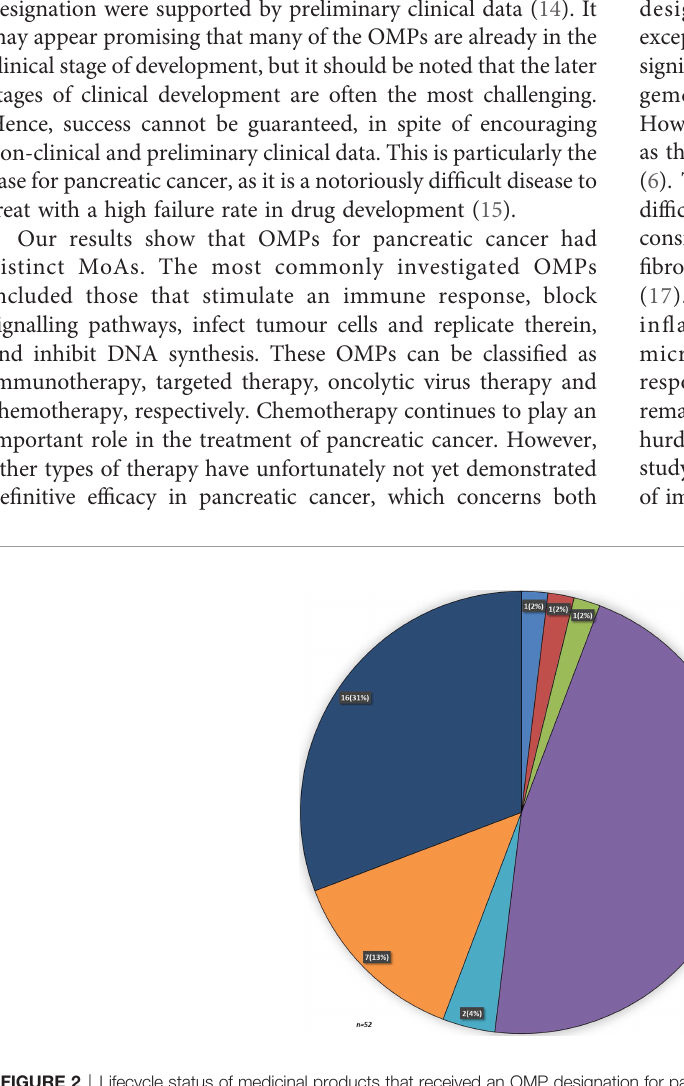
FIGURE 2 | Lifecycle status of medicinal products that received an OMP designation for pancreatic cancer. When a recent annual report was absent the development lifecycle status was labelled as